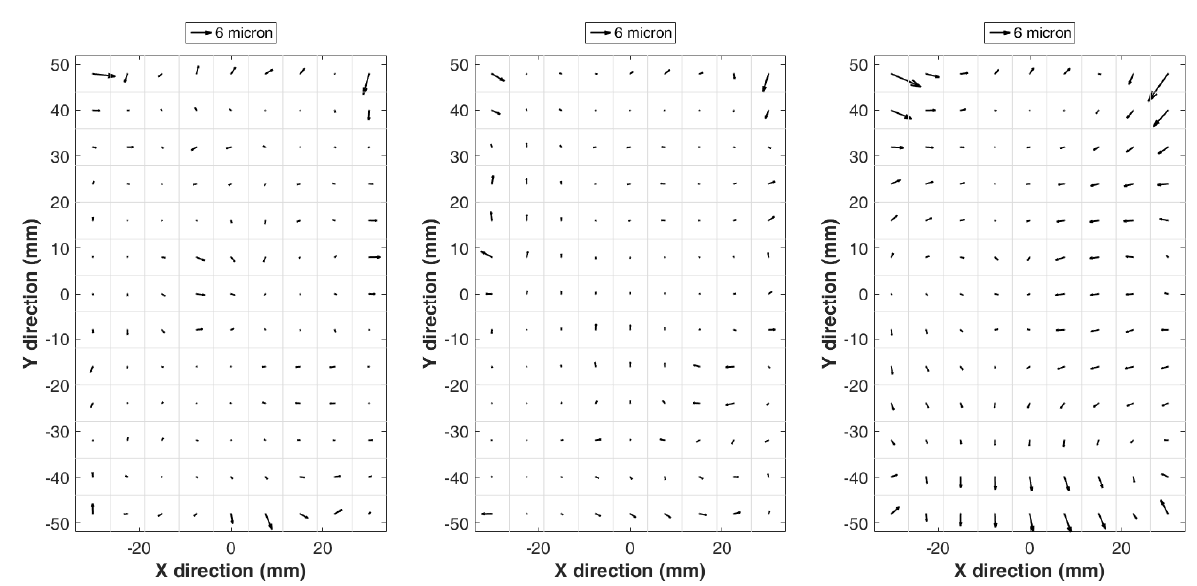
Figure 4. Average image distortion vectors determined by using WAPs in Case 1-2 (left), Case 2-2 (middle), and Case 3-2 (right)